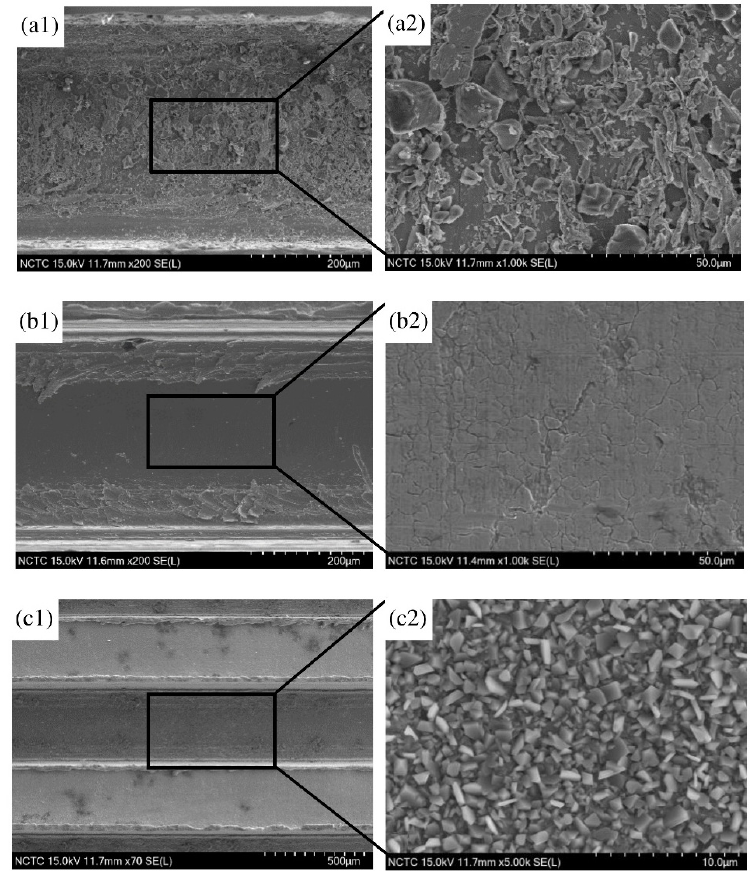
Figure 3. Photograph and surface morphology of the micro-channel plates: ( a1 ) ×200 and ( a2 ) ×1000 before cleansing; ( b1 ) ×200 and ( b2 ) ×1000 after cleansing, with 20% citric acid; ( c1 ) ×70 and ( c2 ) ×50,000 after annealing at 800 °C.